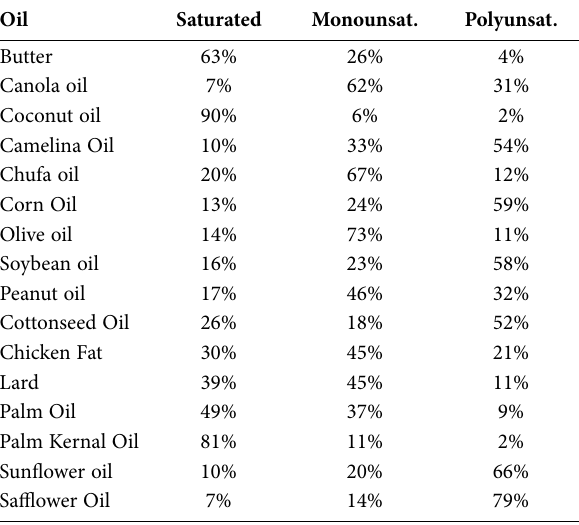
* Note- The values are averaged. Actual values may vary based on the region of growth, genetic modification made, and method of